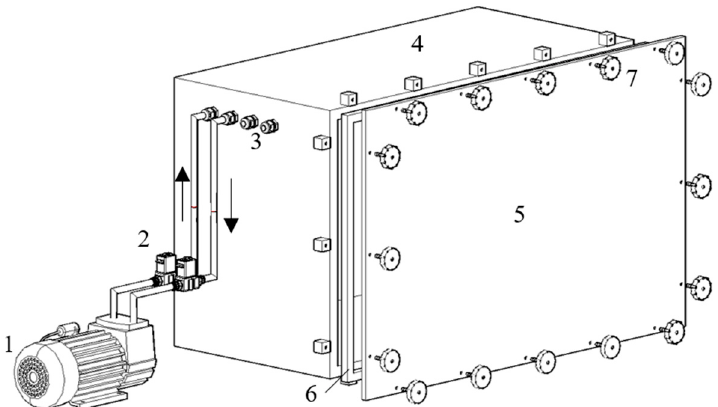
Figure 3. Schematic of the barometric chamber components: (1) pressure/vacuum air pump; (2) pres- sure and vacuum proportional valves; (3) wire connections; (4) barometric chamber box; (5) barometric chamber lid; (6) sealing tape; (7) bolts.